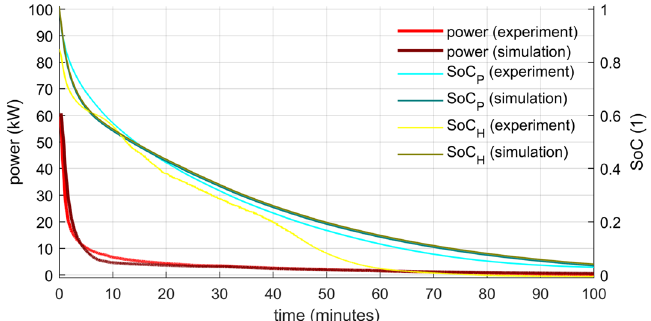
Figure 11. Power and SoC evolution—comparison of the numerical model with the experimental data for higher HTF flow rate.